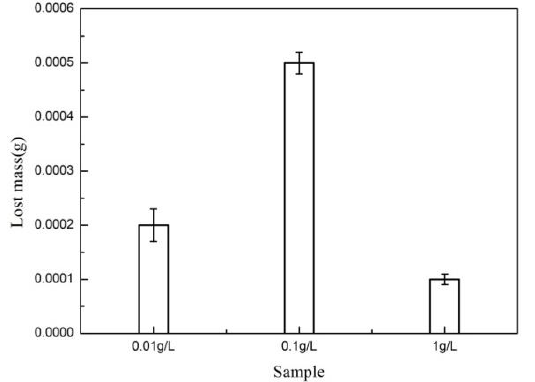
Figure 12. Lost mass of SiC-hydroxyapatite coatings with different SiC particle sizes.